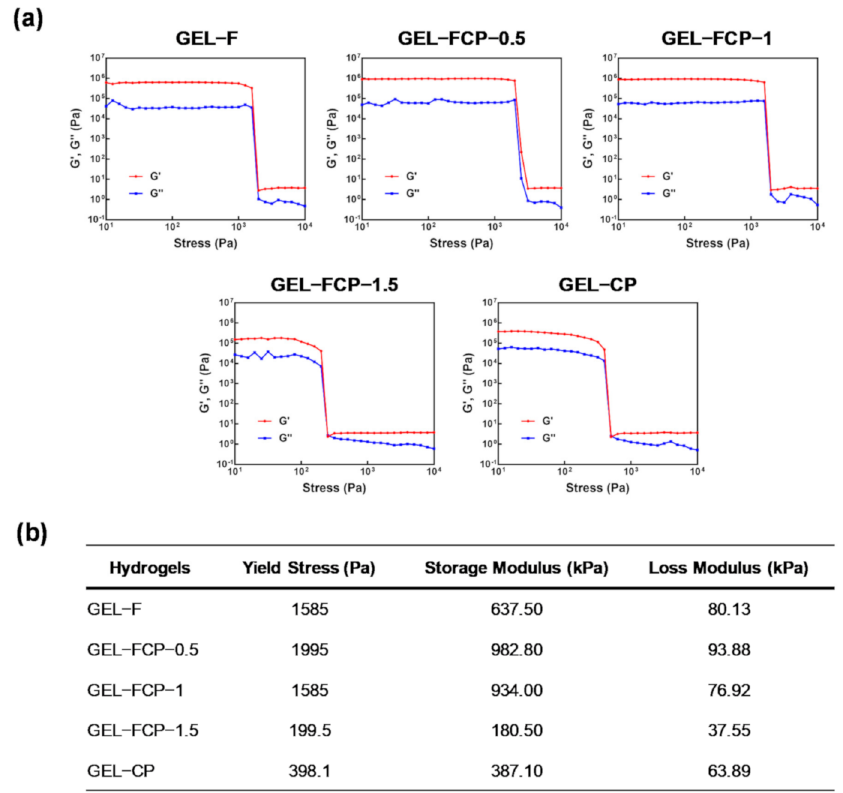
Figure 5. ( a ) G (cid:48) and G (cid:48)(cid:48) determined by oscillatory stress sweep measurements at the frequency of 1 Hz. ( b ) Yield stress, storage modulus (G (cid:48) ), and loss modulus (G (cid:48)(cid:48) ) of each